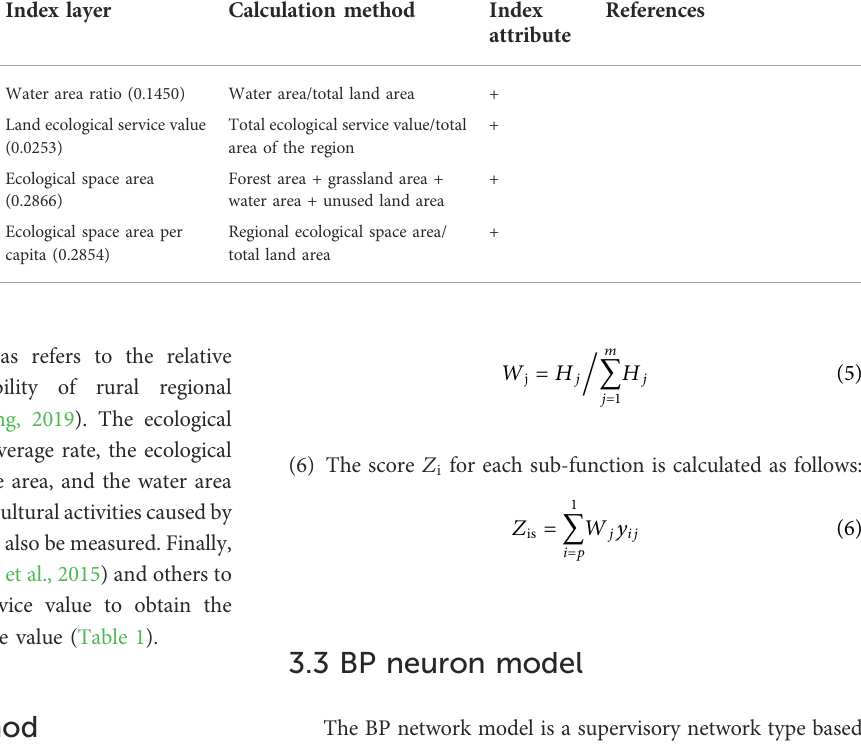
TABLE 1 ( Continued ) Index system and weight of rural regional multi-functionality evaluation. Target